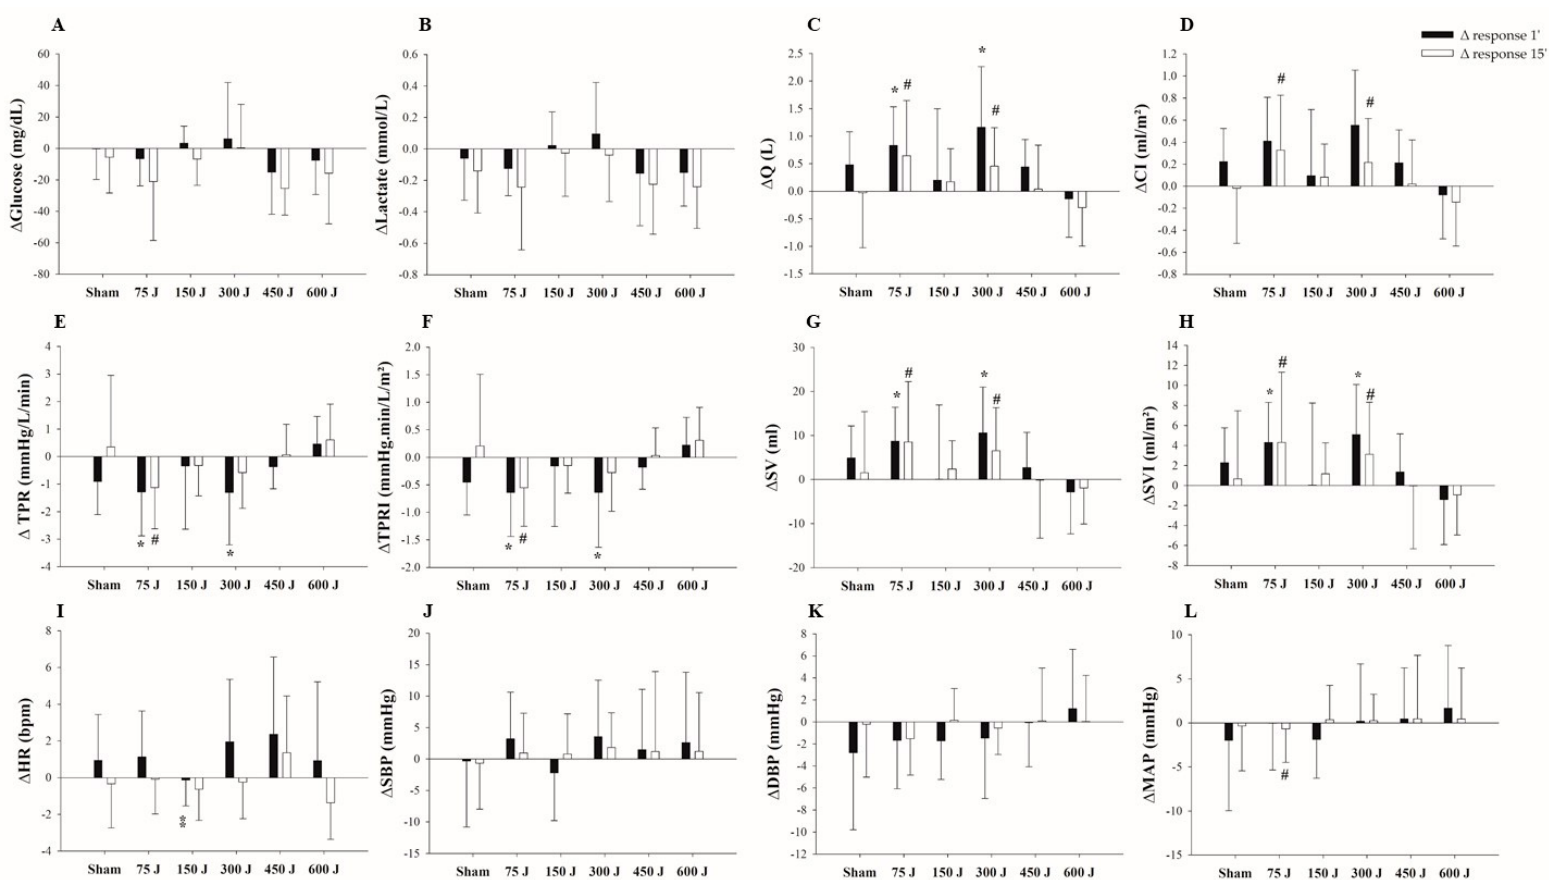
Figure 5. Average and SD deltas ( ∆ ) of ( A ) fasting plasma glucose, ( B ) lactate, ( C ) cardiac output ( Δ𝑄(cid:4662) ), ( D ) cardiac index ( Δ CI), ( E ) total peripheral resistance (TPR), ( F ) total peripheral resistance index ( ∆ TPRI), ( G ) stroke volume ( ∆ SV), ( H ) stroke volume index ( ∆ SVI), ( I ) heart rate ( ∆ HR), ( J ) systolic blood pressure ( ∆ SBP), ( K ) diastolic blood pressure ( ∆ DBP), and ( L ) mean arterial pressure ( ∆ MAP) at 1 min and 15 min post PBM for sham, 75, 150, 300, 450, and 600 J. *: p <0.05 when compared to the energy of 600 J in the moment baseline. #: p <0.05 when compared to the energy of 600 J in the moment 15 min post-PBM. ⁑ : p <0.05 when compared to the energy of 300 J in the moment 1 min post-PBM. #: p <0.05 when compared to the energy of 600 J in the moment 15 min post-PBM.